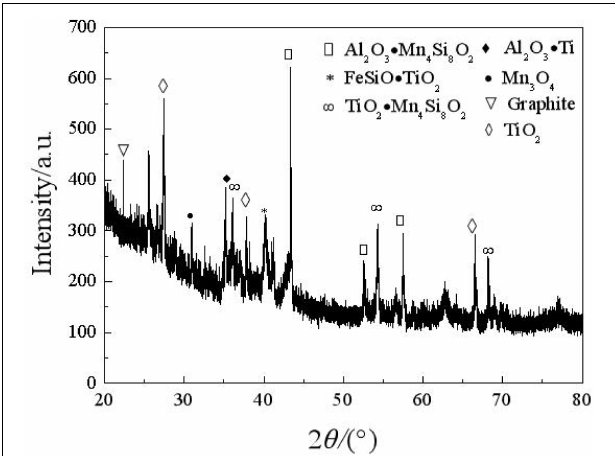
FIGURE 4 | X-ray diffraction map of a carbon deposit.